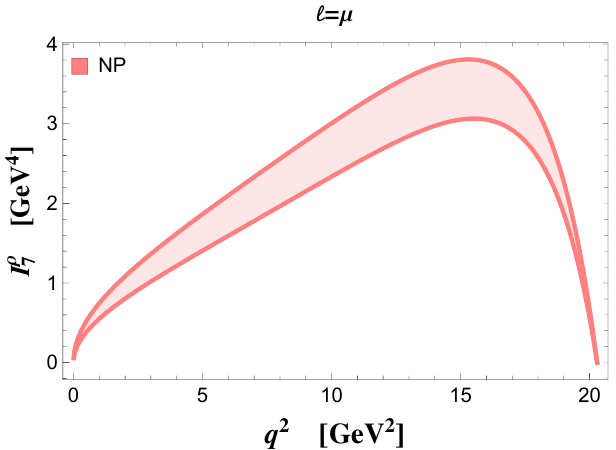
Figure 6. ¯ B → ρ ( ππ ) µ − ¯ ν µ : angular coefficient function in NP at the benchmark point.